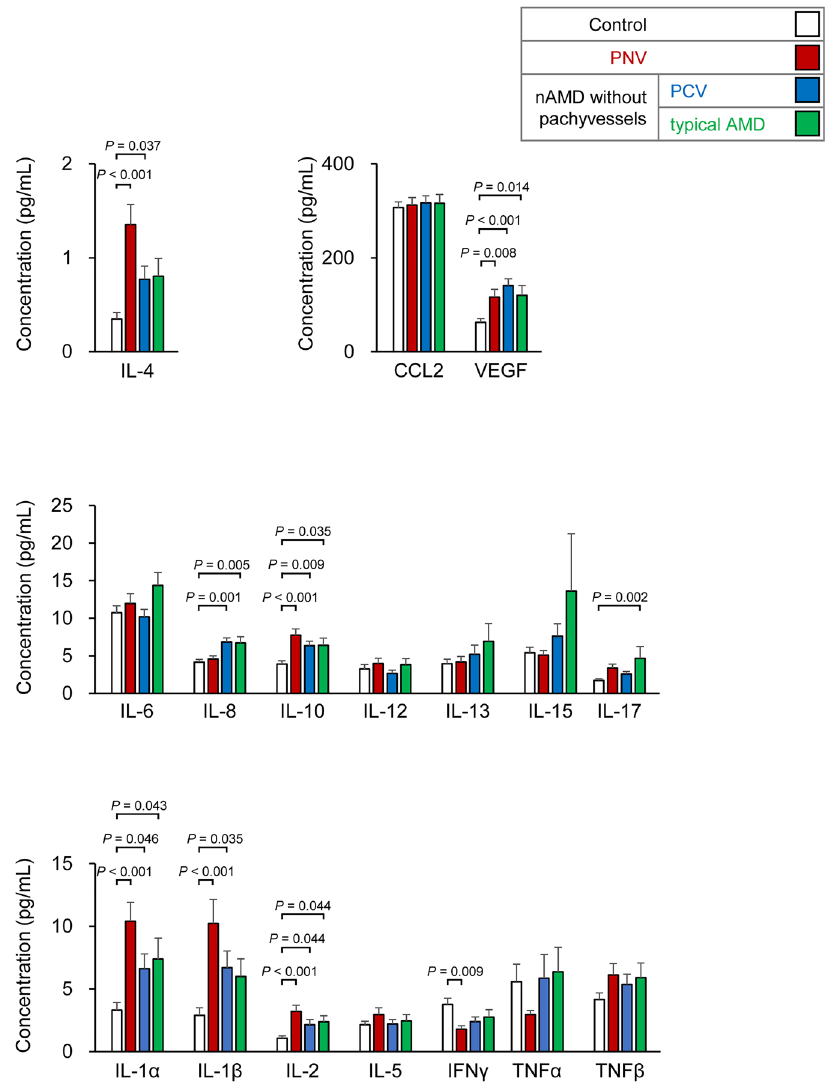
Figure 1. Levels of cytokines in the aqueous humor of eyes with pachychoroid neovasculopathy (PNV), polypoidal choroidal vasculopathy (PCV), typical age-related macular degeneration (typical AMD), and normal subjects. In PNV (red bar), the level of IL-1α, IL-1β, IL-2, IL-4, IL-10, and VEGF were significantly higher than that of the control eyes (white bar). In the PCV eyes (blue bar), IL-1α, IL-1β, IL-2, IL-4, IL-8, IL-10, and VEGF were significantly higher than that of the control eyes. The levels of IL-1α, IL-2, IL-8, IL-10, IL-17, and VEGF were higher in eyes with typical age-related macular degeneration (AMD; green bar) than in the normal control eyes. PNV, pachychoroid neovasculopathy; PCV, polypoidal choroidal vasculopathy; typical AMD, typical age- related macular degeneration. Data are the means (pg/ml) and standard error of the means. PNV, n = 75; PCV, n = 93; typical AMD, n = 52; control, n = 150. ANOVA and post hoc test